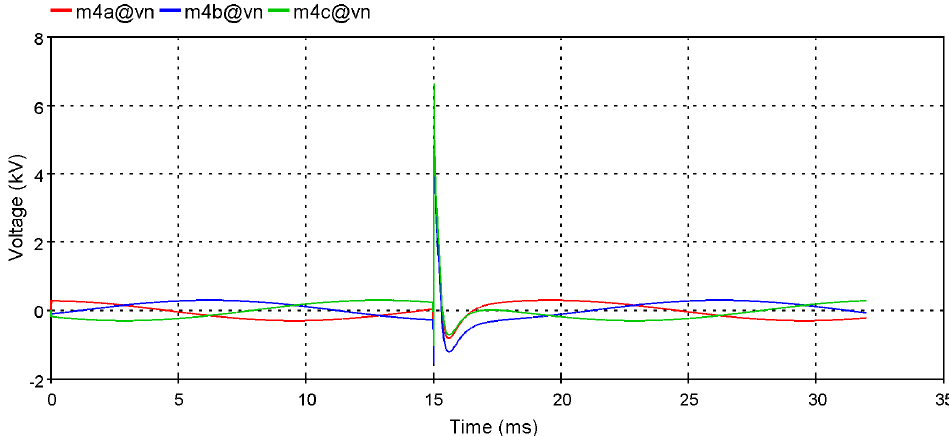
Figure 11. Overvoltage at the secondary side of the auxiliary transformer with SPD.